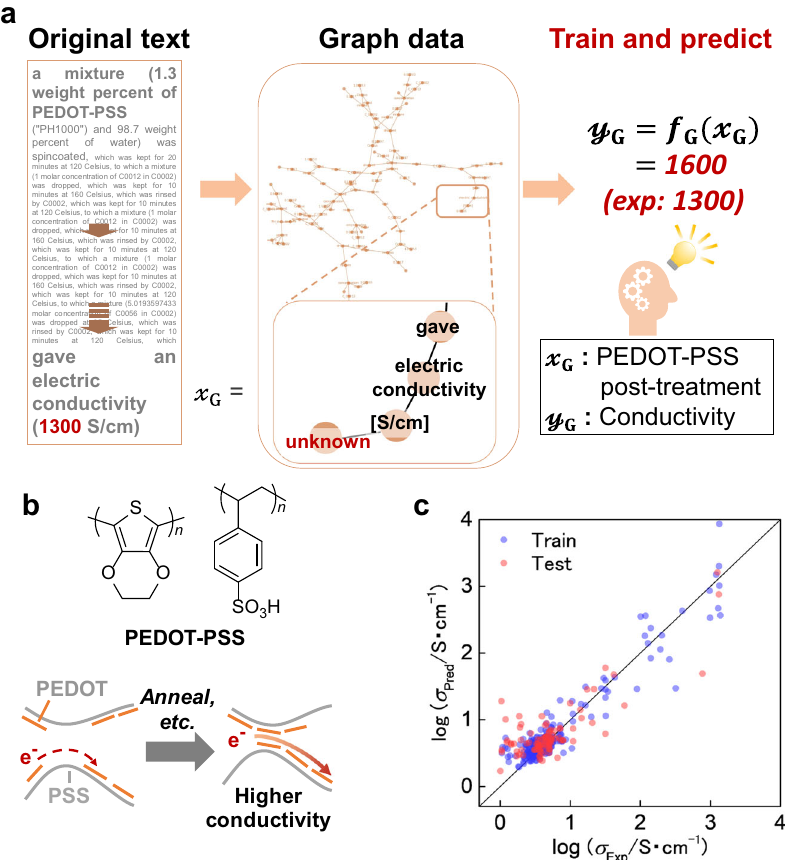
Fig. 3 Prediction of electric conductivity. a Predicting the electrical conductivity of PEDOT-PSS from its post-treatment method. b Structure of PEDOT- PSS. The mixture gives higher conductivity with appropriate post-treatment, which induces the optimum connection of conductive moieties. c Experimental and predicted conductivity of PEDOT-PSS. Seventy percent of data are selected randomly as the training dataset. The rest is used only for prediction. R 2 scores for training and test datasets are 0.87 and 0.70,